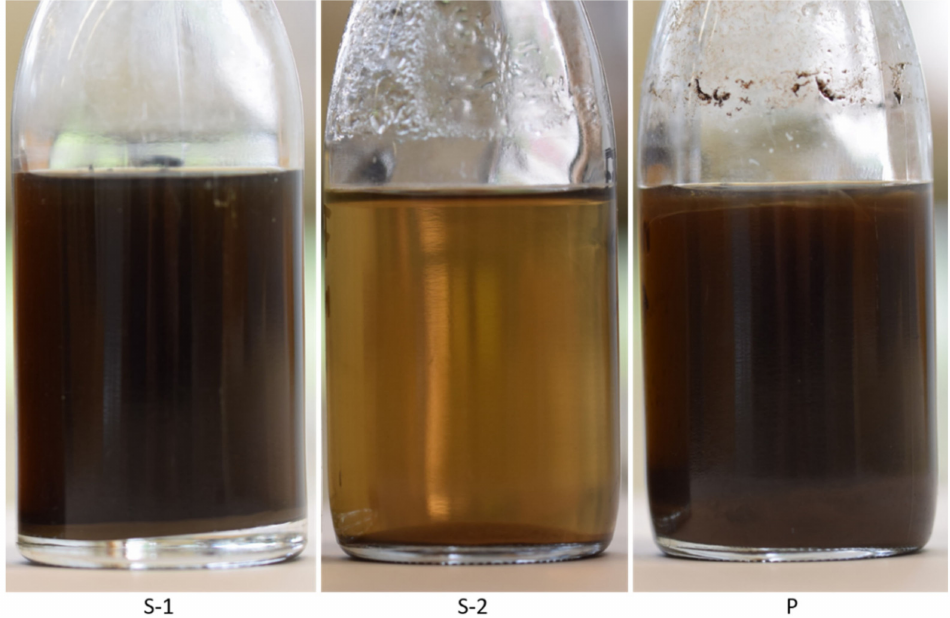
Figure 1. Press waters (PW) produced by the mechanical dewatering press and after autoclaving. Spruce-based PW (S-1 and S-2) and poplar-based PW